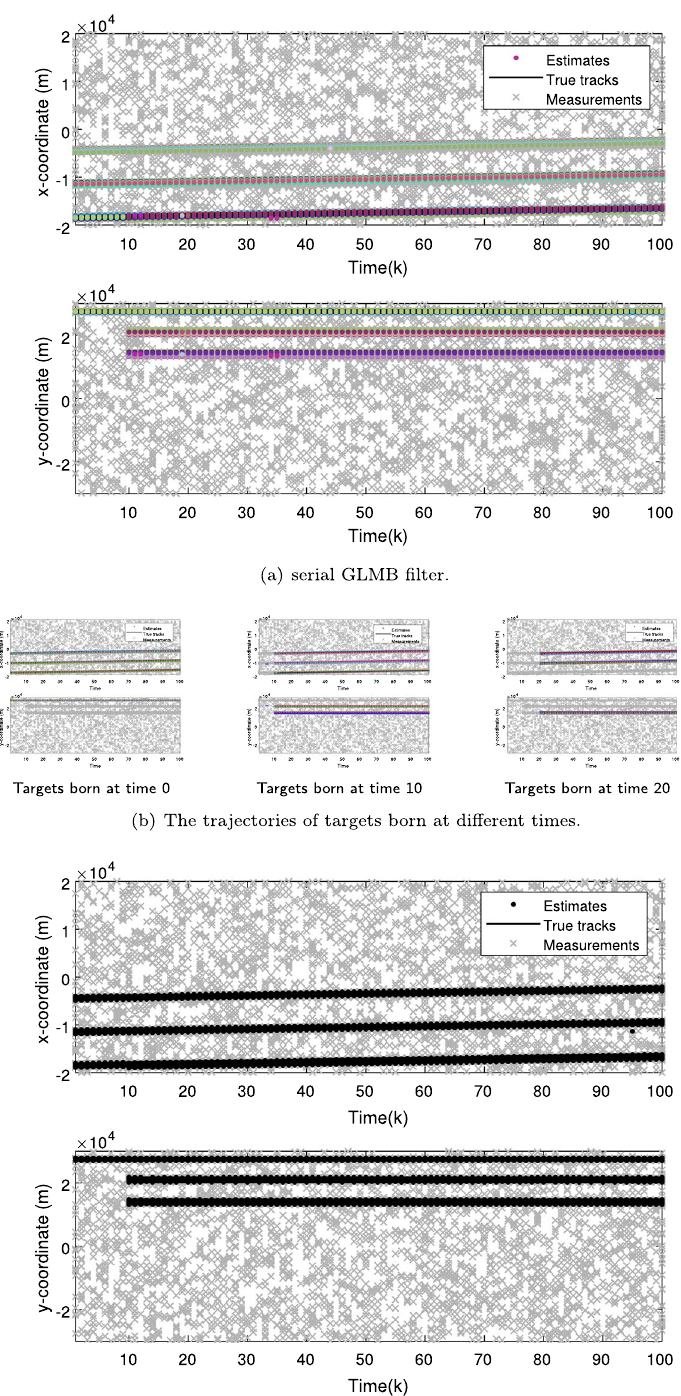
Fig. 9 States estimation of all